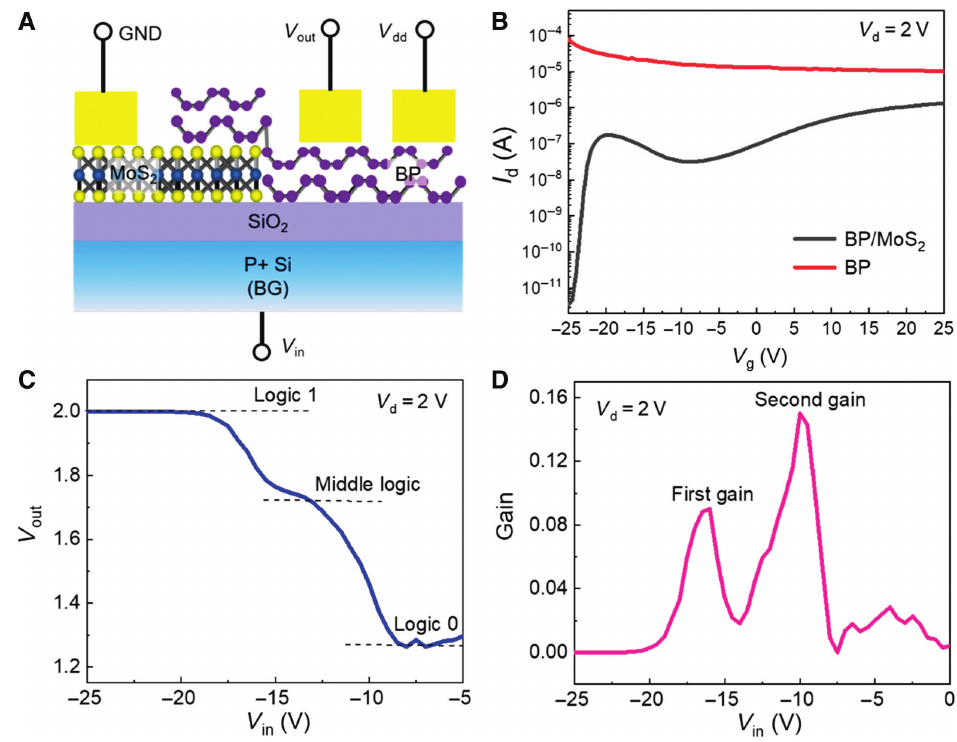
Figure 4: The electrical characteristics of the ternary inverter. (A) Schematic view of a ternary inverter. (B) I the ternary inverter at V